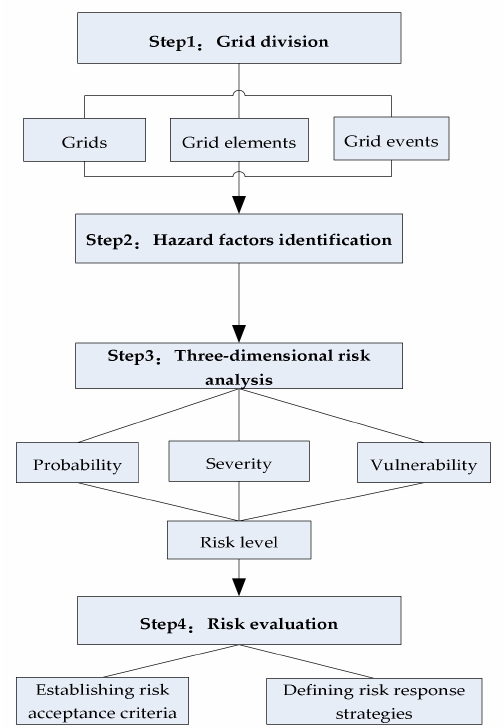
Figure 1. Grid-based three-dimensional risk assessment